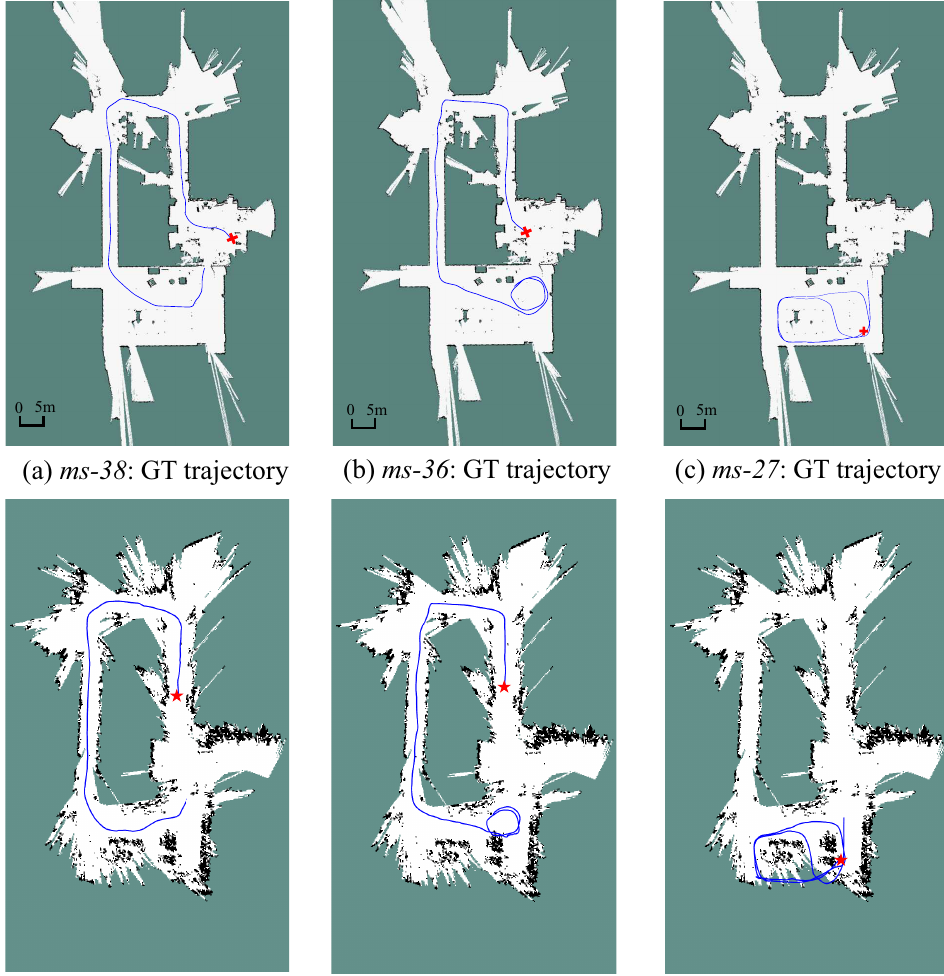
Figure 6. Real-time self-localization trajectories on the MIT Stata benchmark dataset. The first row plots the trajectory with ground truth. The second row depicts the trajectories estimated by the proposed localization method. The red cross marks in ( a – c ) are the initial locations of the robot. The red star marks in ( d – f ) are the locations where MCL method is converged (also the position where the trajectories start to be recorded).